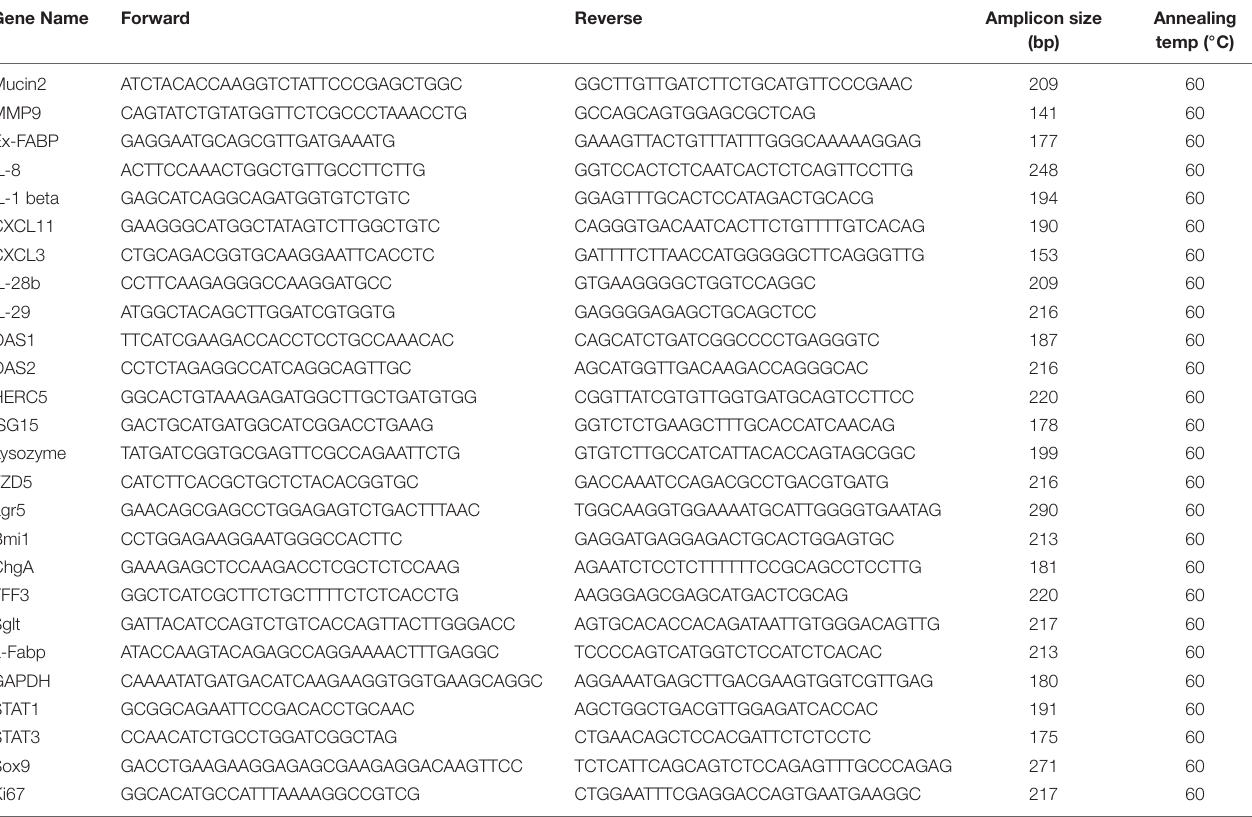
TABLE 1 | Primer sequences used in this